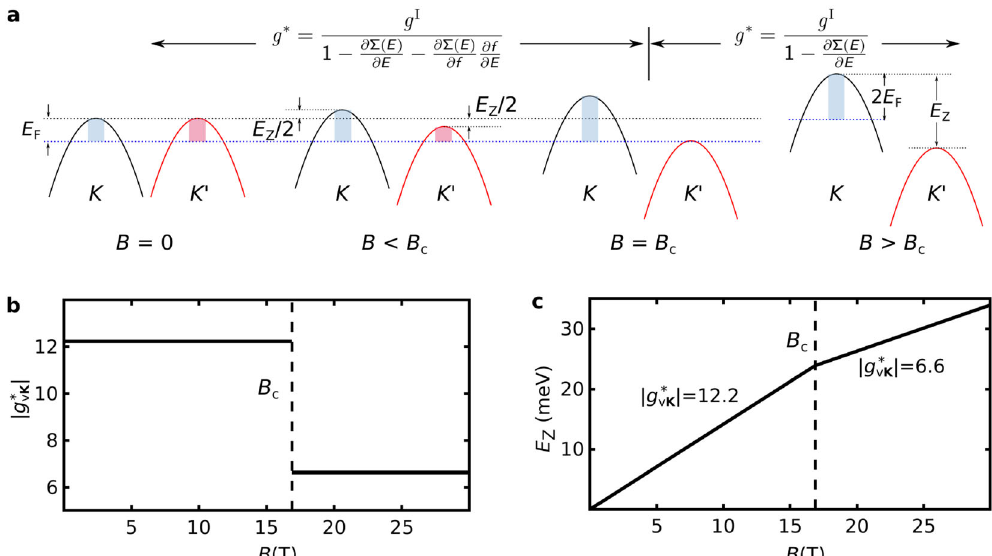
Fig. 2 Magnetic fi eld dependence of g-factor. a Schematic fi gure illustrating the Zeeman effect as B is increased with fi xed hole density. The black and red curves represent spin-up and spin-down bands, respectively. The pink and blue shaded regions illustrate the magnitude of hole density due to the constant density of states in the quadratic band in two dimensions. As B increases for B ≤ B c , the absolute Fermi level position is unchanged, but the band occupancies change. For B > B c , the Fermi level shifts with the band at K and the band occupancies remain unchanged. b , c Plots of b ∣ g * ∣ and c valley Zeeman split E Z (labeled in a ) as a function of magnetic fi eld B for monolayer WSe 2 with hole density 2.5 × 10 12 cm − 2 , which corresponds to E F = 12.2 meV (see panel a for the de fi nition of E F ).